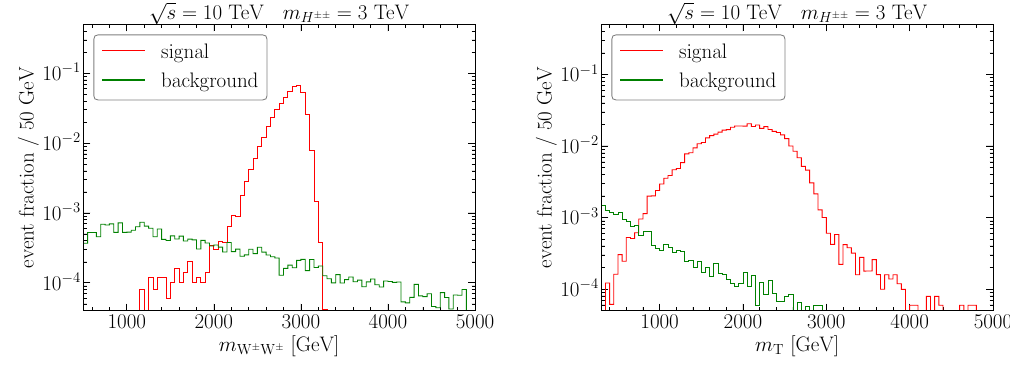
Figure 13 . The invariant mass of W ± W ± (left) and the transverse mass m T (right) from H ±± → √ = 3 TeV. W ± W ± channel, with s = 10 TeV and m H ±±